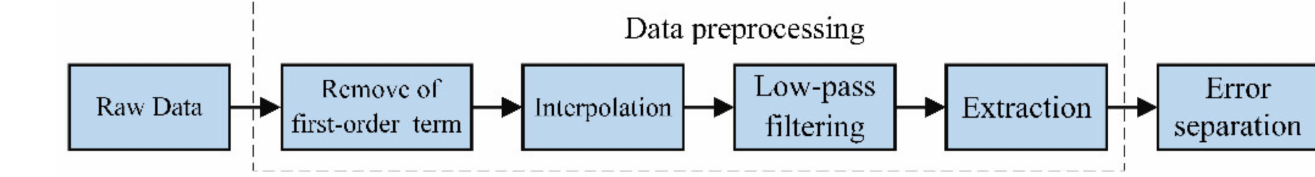
Figure 6. The flowchart of data preprocessing.